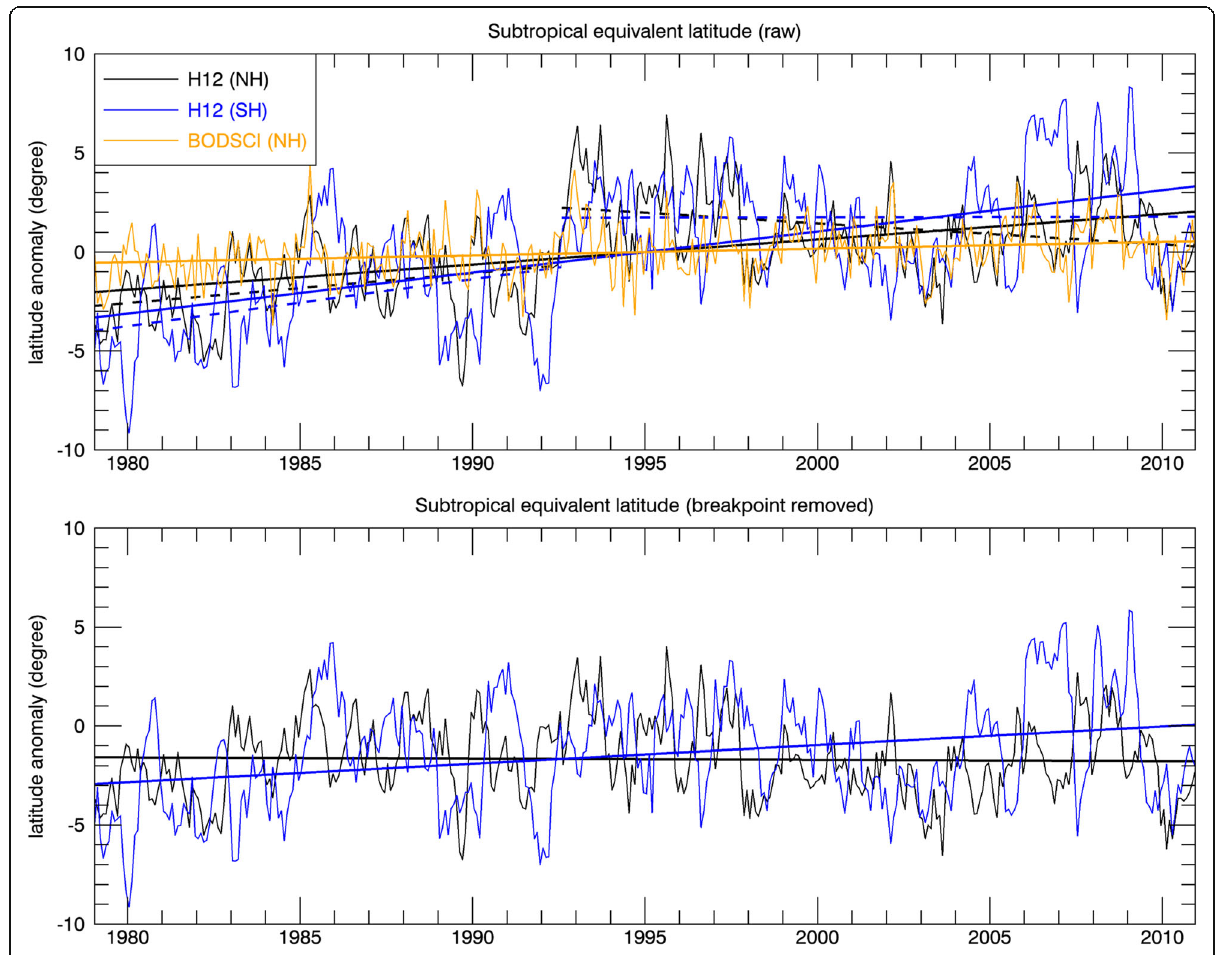
Fig. 3 Top panel: Timeseries analysis illustrating an undocumented changepoint in the Hudson 2012 metric (black, blue lines) and our implementation using the BODSCI TCO data (yellow line). Lower panel: the reconstructed timeseries with breakpoint